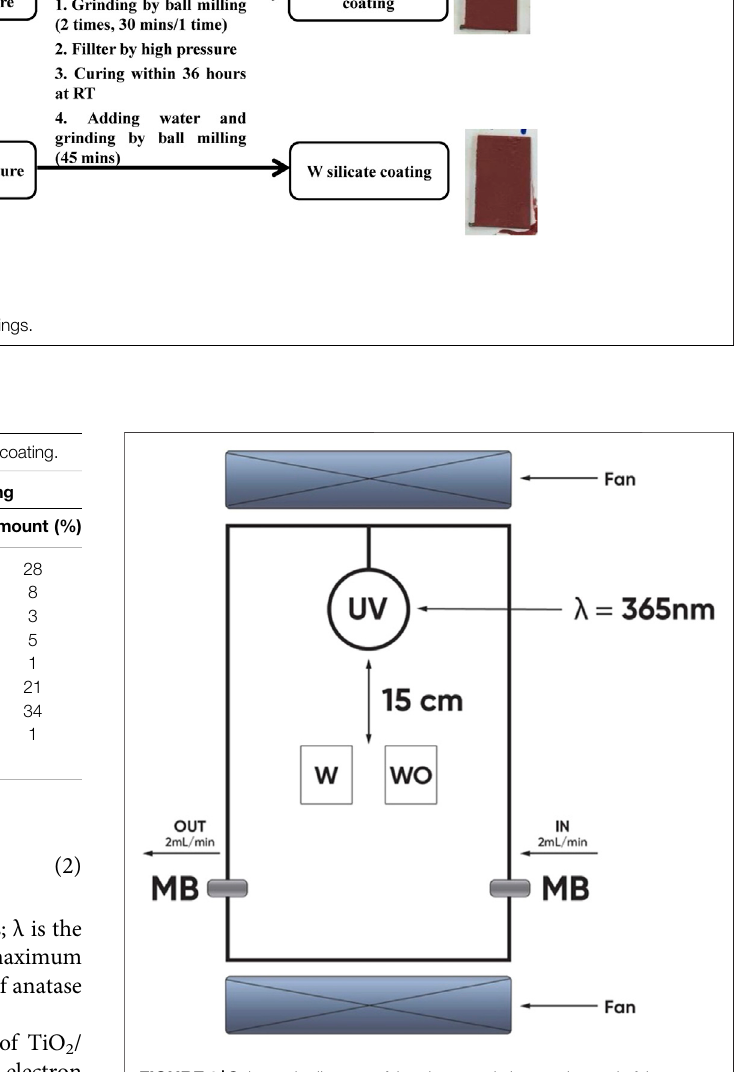
FIGURE1| Schematicdiagramofthephotocatalyticexperimentalofthe WO and W silicate